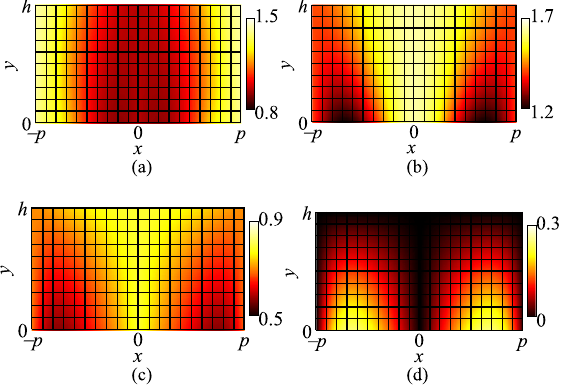
Fig. 7. Calculated characteristic impedances and electric lengths for the bump illusion of Figure 2. (a) Normalized characteristic impedance Z 0 x / h . (b) Normalized characteristic impedance Z 0 y / h . (c) Normalized electrical length b l / k D d . (d) Normalized electrical length b M l M / k D d